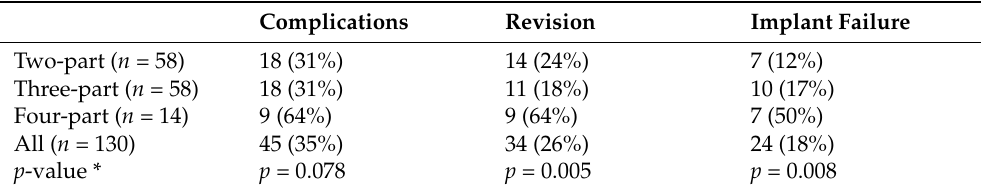
Table 4. Incidence of complications, revisions, and implant failures in respect to two-, three-, and four- part fractures; * p -value of the χ 2 = Pearson’s chi-square comparing the difference of the three subgroups. Complications Revision Implant Failure